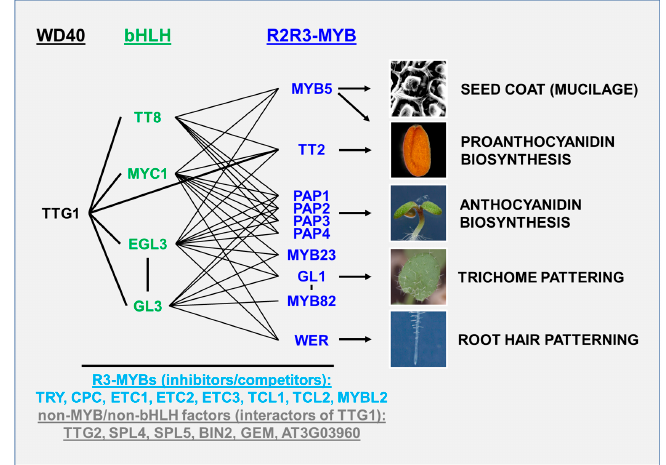
Figure 2. AtTTG1 -dependent gene regulatory network. Proteins encoded by the AtTTG1 -dependent gene regulatory network and possible differential MBW(AtTTG1) complex formation, regulating the five major AtTTG1 -dependent traits. Shown are all bHLH and R2R3-MYB proteins that can form a ternary complex with AtTTG1 and regulate one of the five major AtTTG1 -dependent traits indicated on the right. Lines represent interactions as documented in the BioGrid database (www.thebiogrid.org) [39]. Inhibitors/competitors compete with respective R2R3-MYBs for binding to bHLH proteins. We also extracted from the BioGrid database non-MYB and non-bHLH factors that interact with TTG1 and added the recently found interactors SPL4 and SPL5. Interactions are documented in a variety of papers [40–53]. For the inhibitors, see e.g., [54–56]. The seed coat picture was acquired by Hans-Peter Bollhagen. Photography of the seedling was done by Siegfried Werth. TTG1: TRANSPARENT TESTA GLABRA 1, GL3: GLABRA3, EGL3: ENHANCER